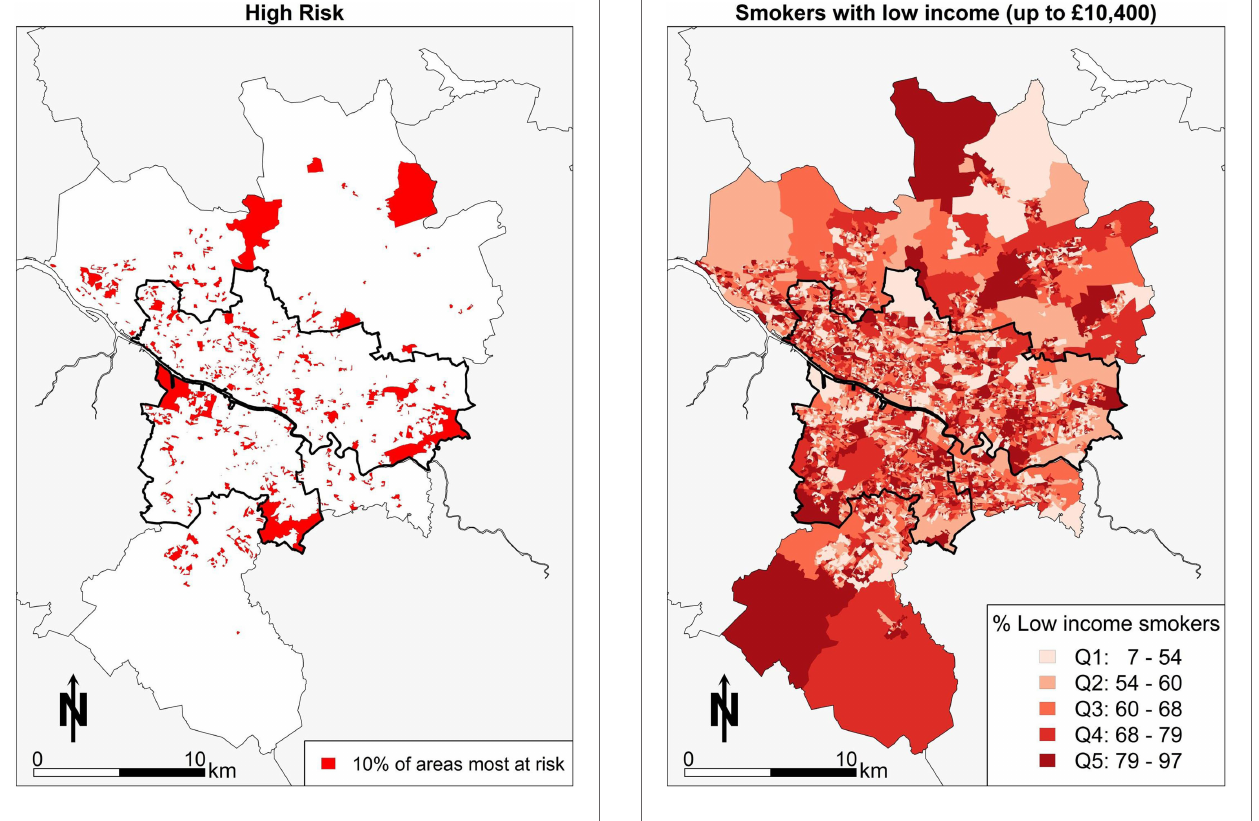
FigUre 7 | low income and smoking . FigUre 6 | combined high risk map